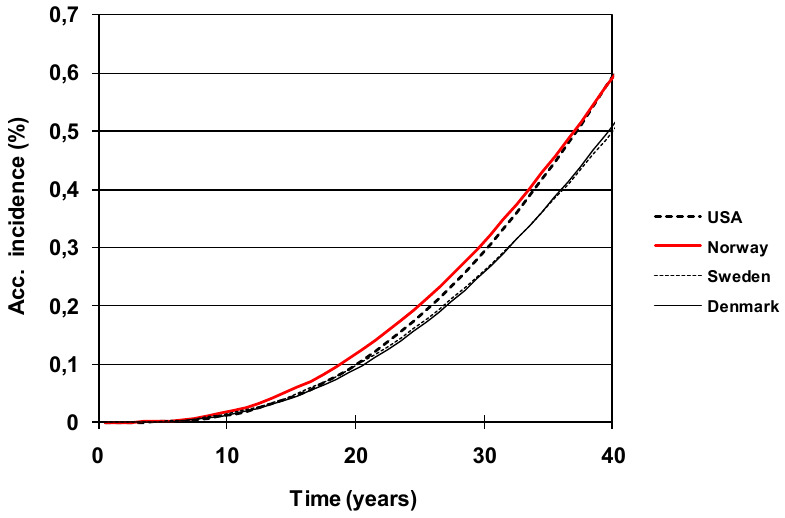
Figure 12. Characteristic functions for Exposure-Time-Specific-Incidence from FM-radiation in Sweden, Norway, Denmark and the USA